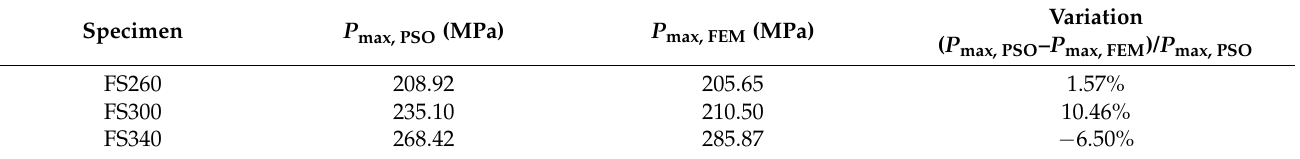
Figure 18. Summary of optimized relative values. Table 4. Comparison between PSO and FE results.